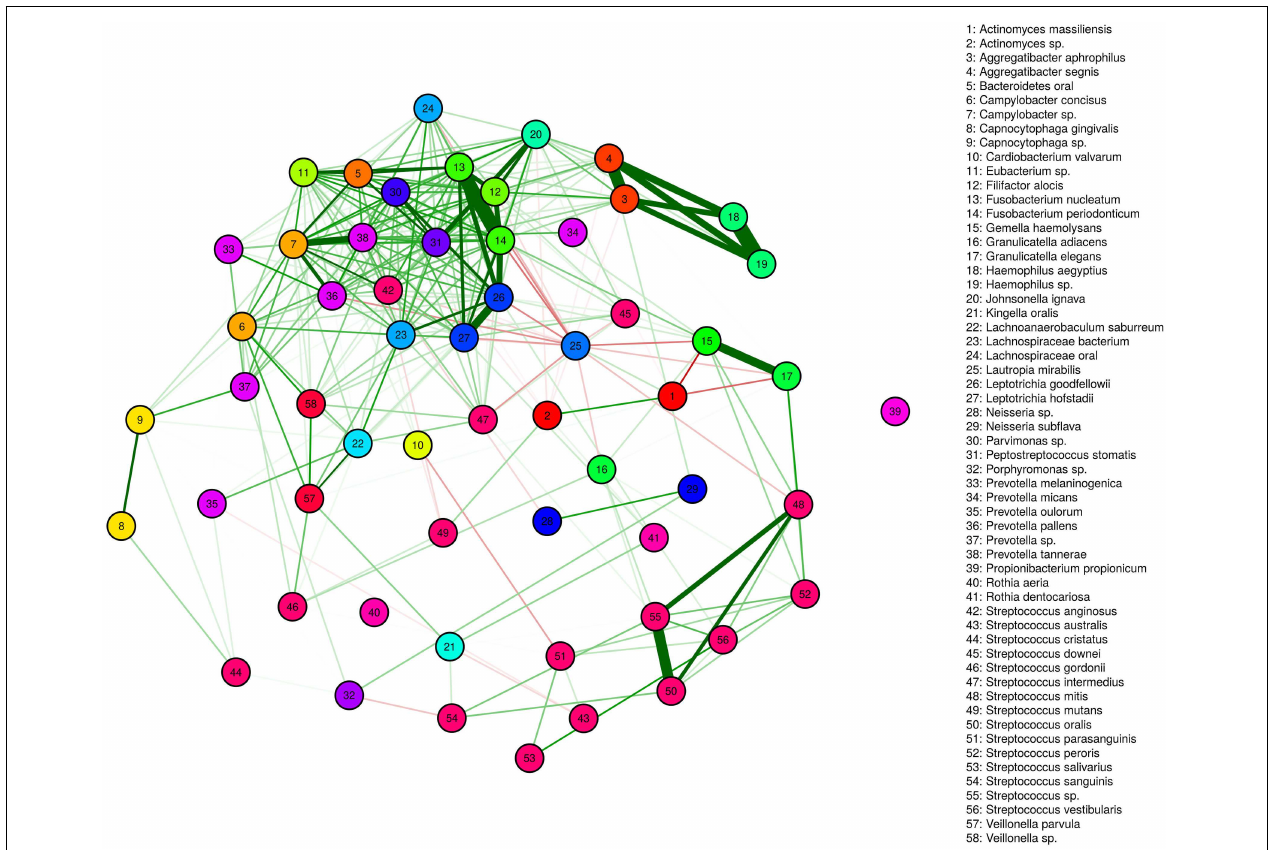
FIGURE 5 | Functional Networks. Positively correlated (green) and anti-correlated (red) transcripts define networks. The thickness of lines indicates the strength of the